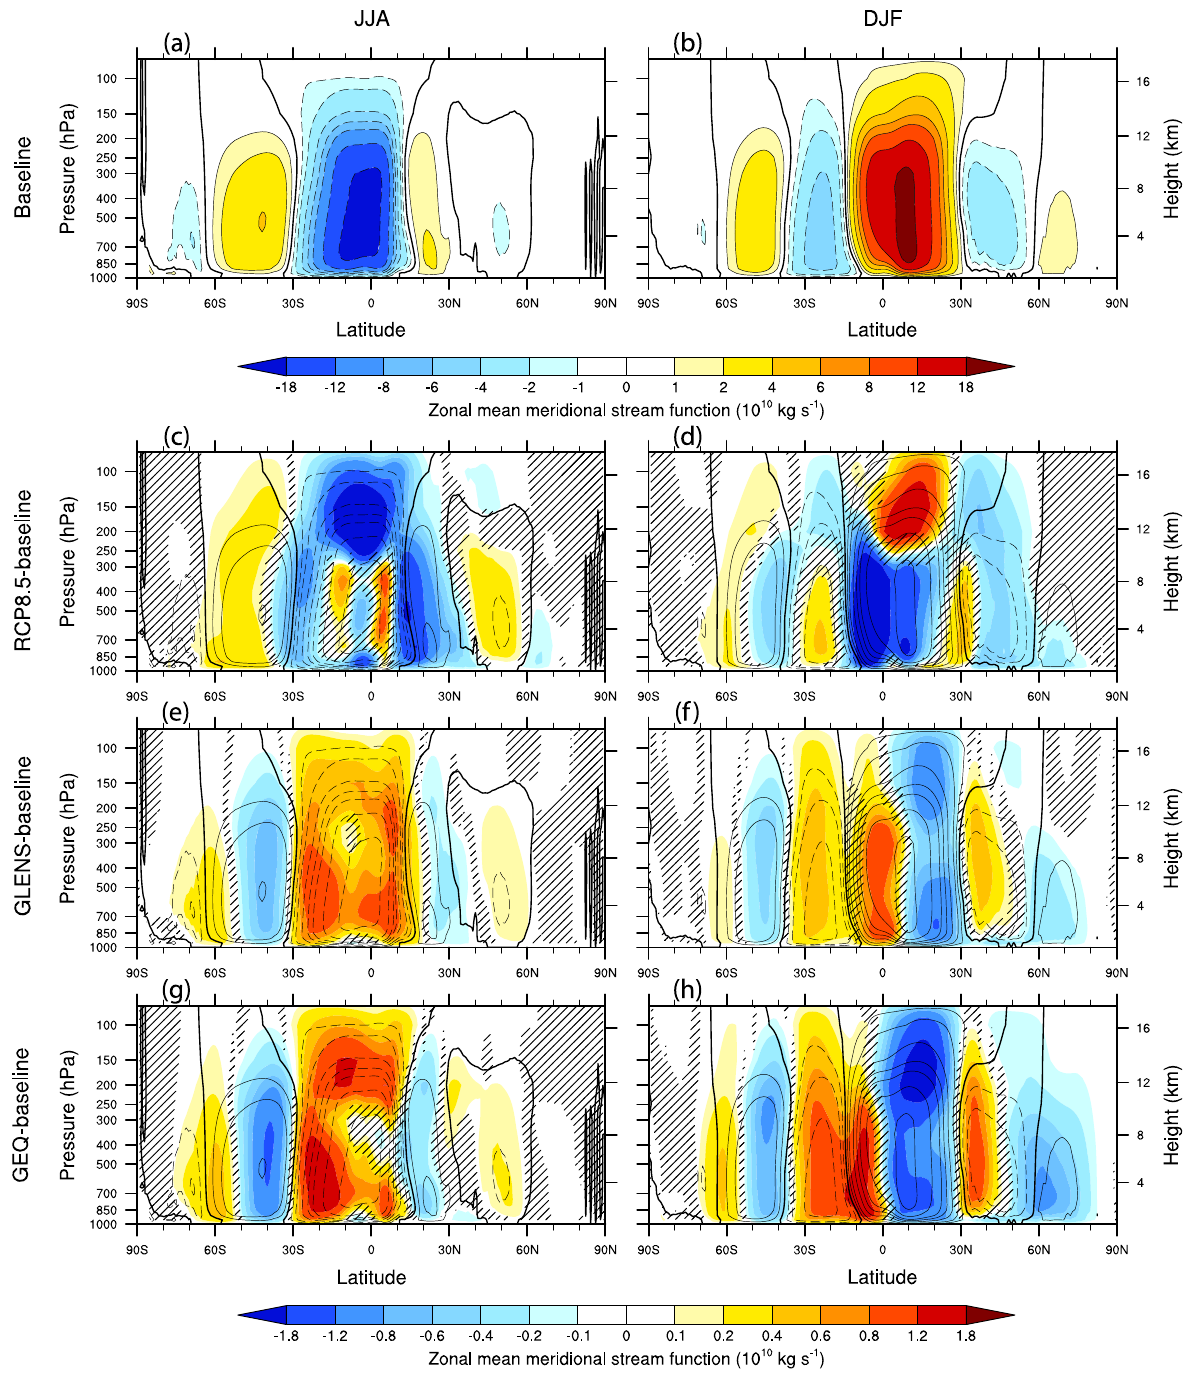
Fig. 2 Zonally seasonal mean meridional mass stream function and its changes. Ensemble and zonal mean JJA ( a , c , e , g ) and DJF ( b , d , f , h ) meridional mass stream function (10 10 kg s − 1 ) in RCP8.5 averaged over the years 2010 – 2030 (baseline; a , b ), and anomalies in the RCP8.5 ( c , d ), GLENS ( e , f ) and GEQ ( g , h ) averaged over years 2075 – 2095, relative to the baseline. Warm colors (positive values) indicate a clockwise rotation and cold colors (negative values) indicate an anticlockwise rotation. Contours indicate the value of seasonal averaged meridional mass stream function (10 10 kg s − 1 ) in the baseline. Hatched areas are regions where changes are not statistically signi fi cant at the 5% level using the Student ’ s t GEOHEATS in JJA (Fig. 3). There is a 2.9 ± 0.7% HC intensity weakening under GEQ. The change in HC intensity under GEQ is Geoengineering in GLENS shows an overcompensation of slightly smaller than that under GLENS, which is associated with HC intensity in global warming, with a 3.5 ± 0.4% reduction in no statistically signi fi cant change in ψ m between the equator and HC intensity during JJA. Under GLENS, the change in simulated HC intensity is approximately equivalent to the sum of 2.2 ± 0.8% 10°S from 300 to 400 hPa. In the above-mentioned simulations, weakening under Solar3x3 and 1 ± 0.7% weakening under the increases in HC intensity under global warming all are over